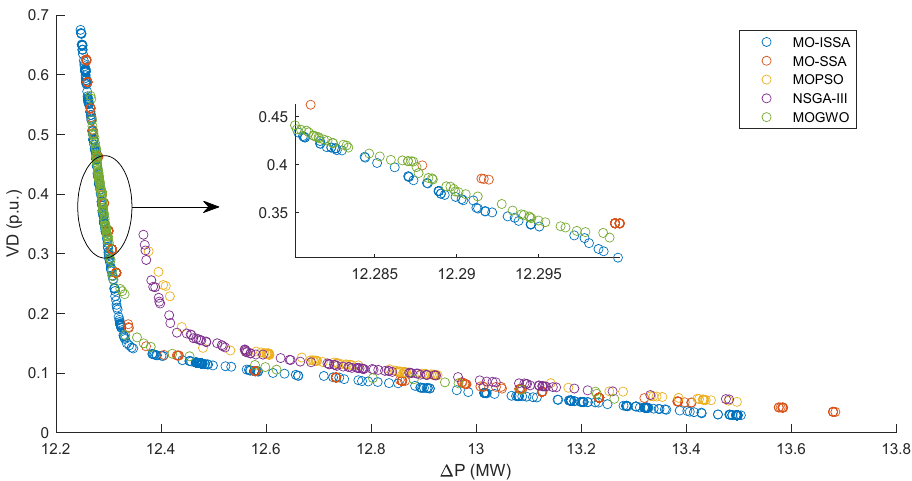
Figure 7. Pareto fronts for IEEE 14-bus system.